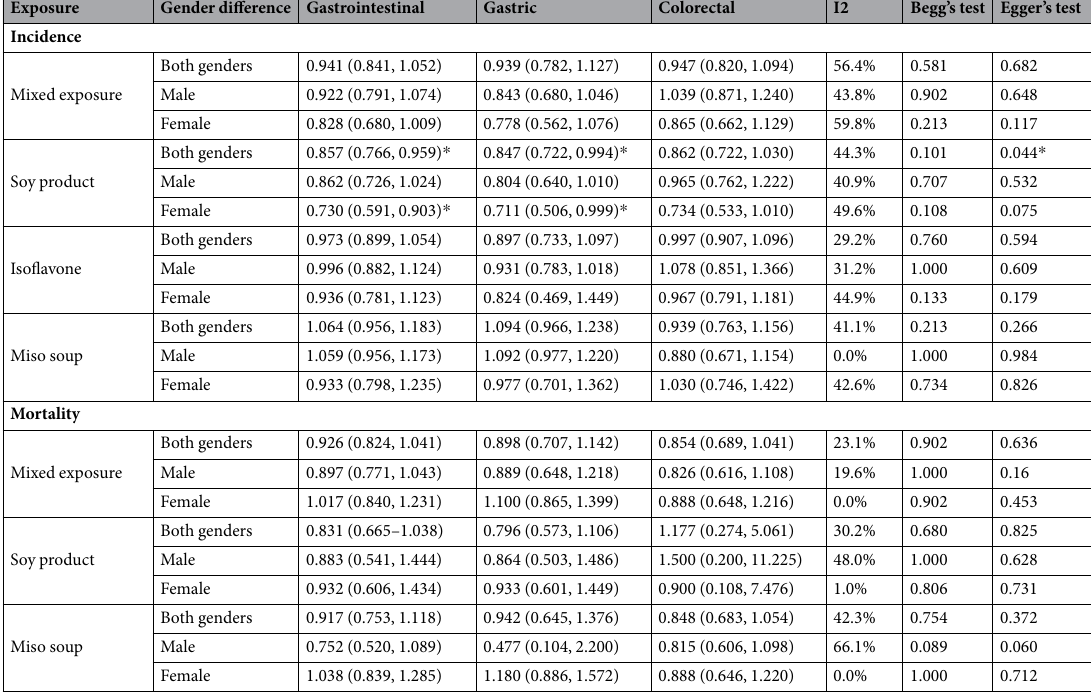
Table 3. Pooled risk estimates between lowest categories compared with highest categories of soy consumption and gastrointestinal cancer risk. * Statistically significant (P <